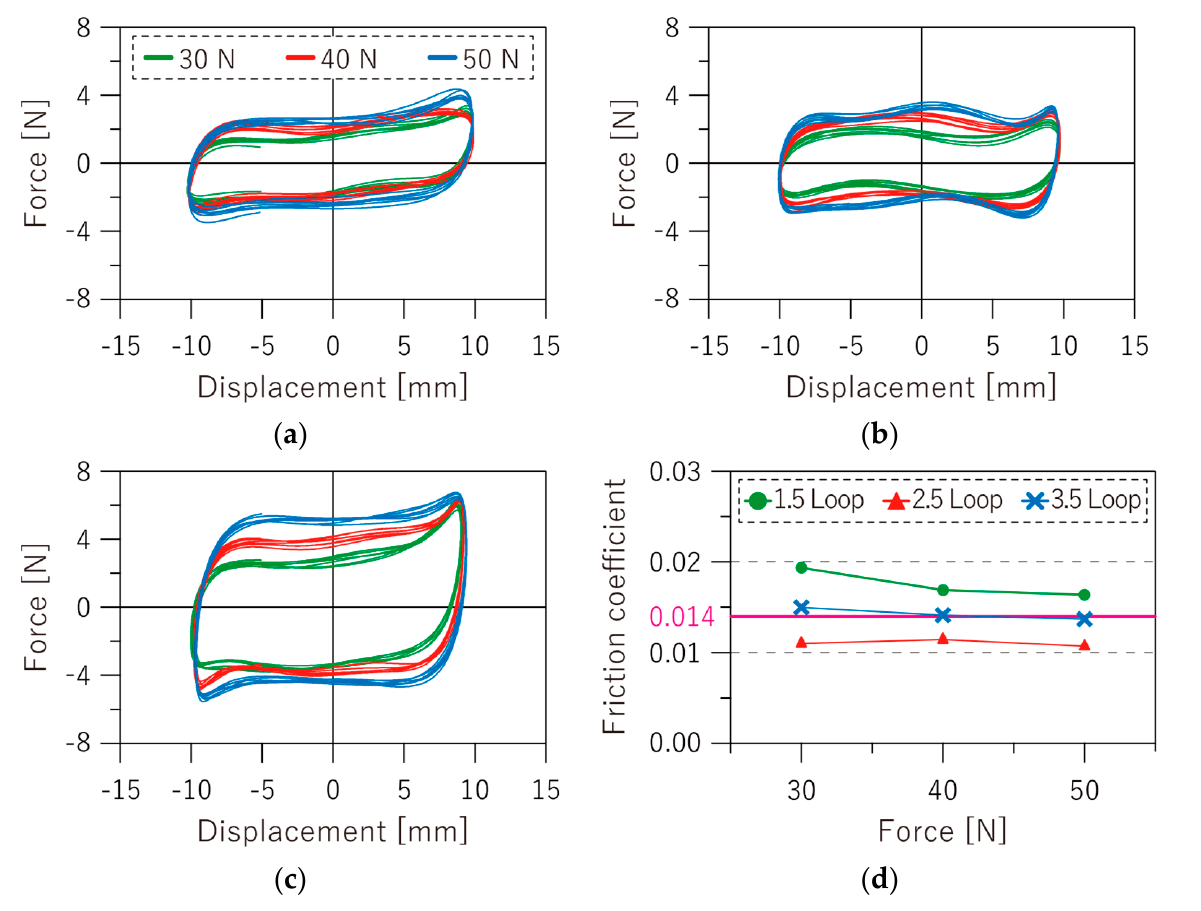
Figure 7. Experimental results of the pulley-friction test: ( a – c ) Force–displacement relationship under different number of the wire-cable loop and ( d ) friction coefficient with the average value.